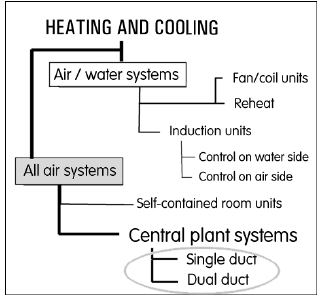
Fig. 2 Alternative principles of heat transport and control for comfort environment in